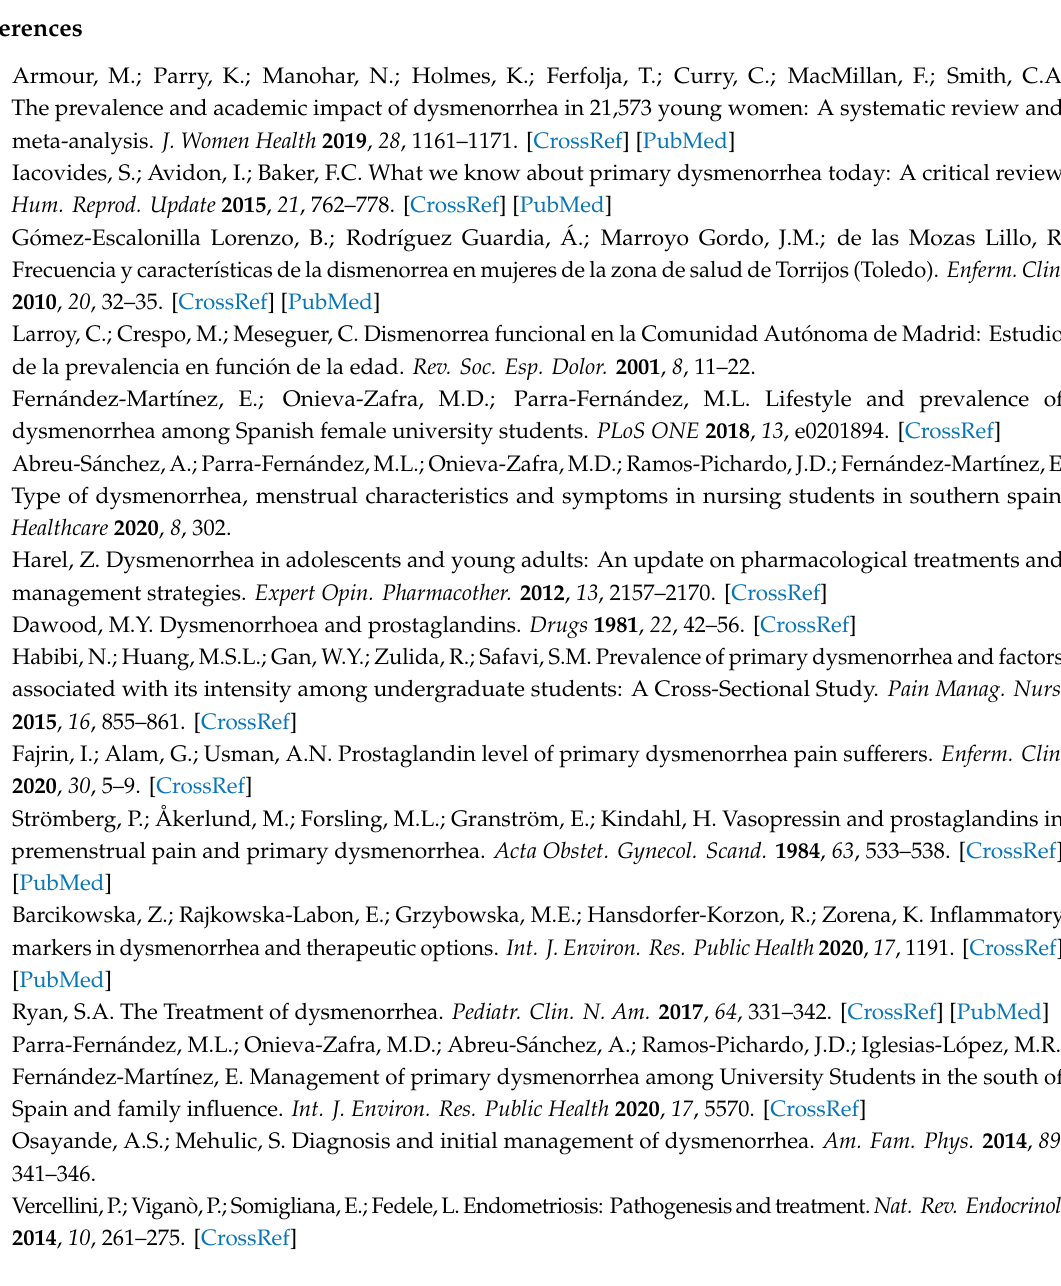
Table S1: Themes that emerged from participant narrative; Table S2: Themes, subthemes, and codes that emerged from Focus